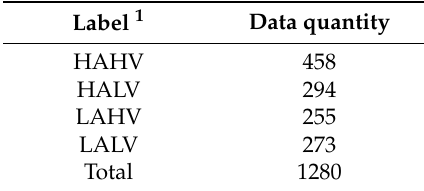
Table 1. The number of extracted wavelet transformed data for two types of labels. Label 1